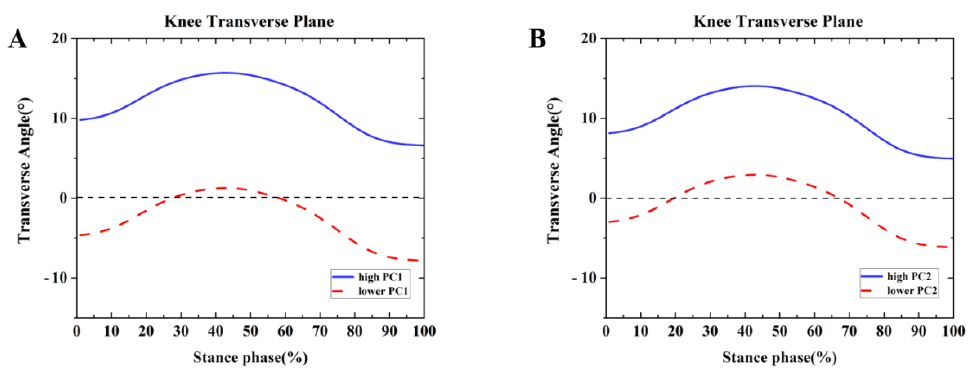
Figure 7. Principal components are retained for the knee. ( A ) The waveform differences between competitive runners and recreational runners of reconstruction principal using the high and lower PC1-scores in the transverse plane. ( B ) The waveform differences between competitive runners and recreational runners of reconstruction principal using the high and lower PC2-scores in the transverse plane.